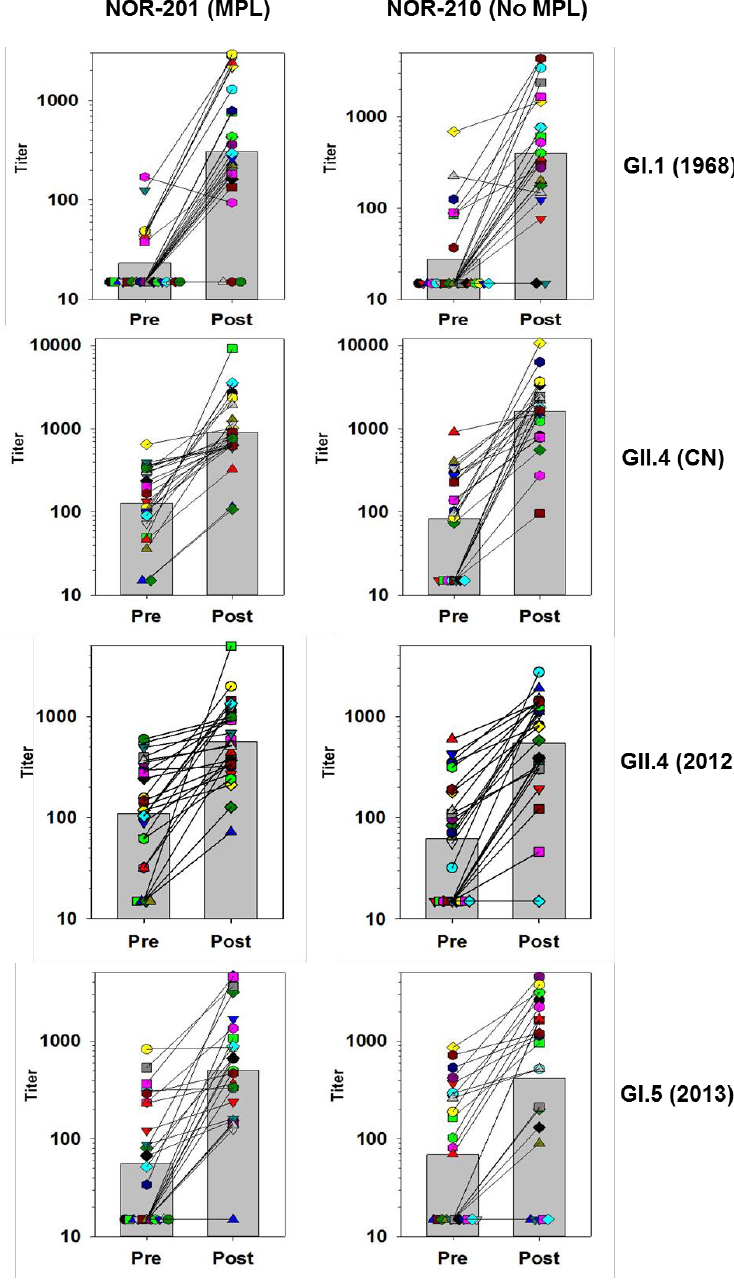
Figure 1. Blockade titers specific for GI.1 (1968), GII.4 (CN), GII.4 (2012), and GI.5 (2013) measured in individual sera before and after vaccination with TAK-214 in the NOR-201 and NOR-210 clinical trials. The subjects tested from NOR-201 were given vaccine that contained MPL adjuvant and subjects in NOR-210 received vaccine without MPL. Individual subjects are different colors and matched sera results are connected by solid lines. The bars in the background represent the geometric mean titer of the subjects. Samples below the assay lower limit of quantitation of 30 are assigned a value of